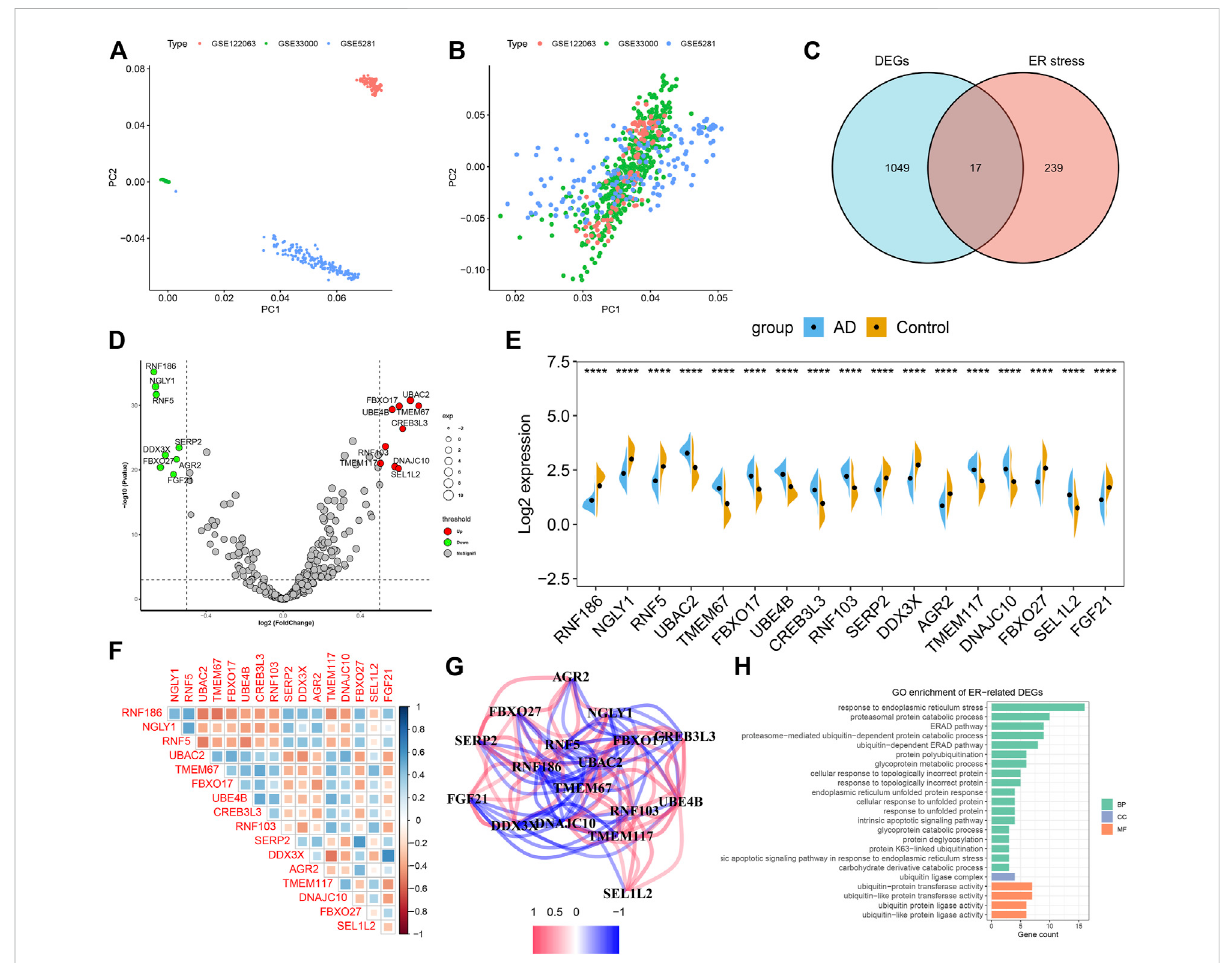
FIGURE 2 Identi fi cation of dysregulated CRGs in AD. (A,B) Principal component analysis (PCA) of three datasets before (A) and after (B) batch effect removal. (C) Representative venn diagram shows 17 ER stress-related DEGs. (D) Representative volcano plot shows the upregulated and downregulated DEGs associated with ER stress. (E) Representative violin diagram showed the expression of 17 ER stress-related DEGs between AD and non-AD controls. **** p < 0.0001. (F) Correlation analysis among 17 ER stress-related DEGs. Blue and red color represents positive and negative correlation, respectively. The area of the rectangular box represents the different correlation coef fi cients. (G) Gene relationship network diagram of 17 ER stress-related DEGs. (H) Go enrichment analysis of 17 ER stress-related